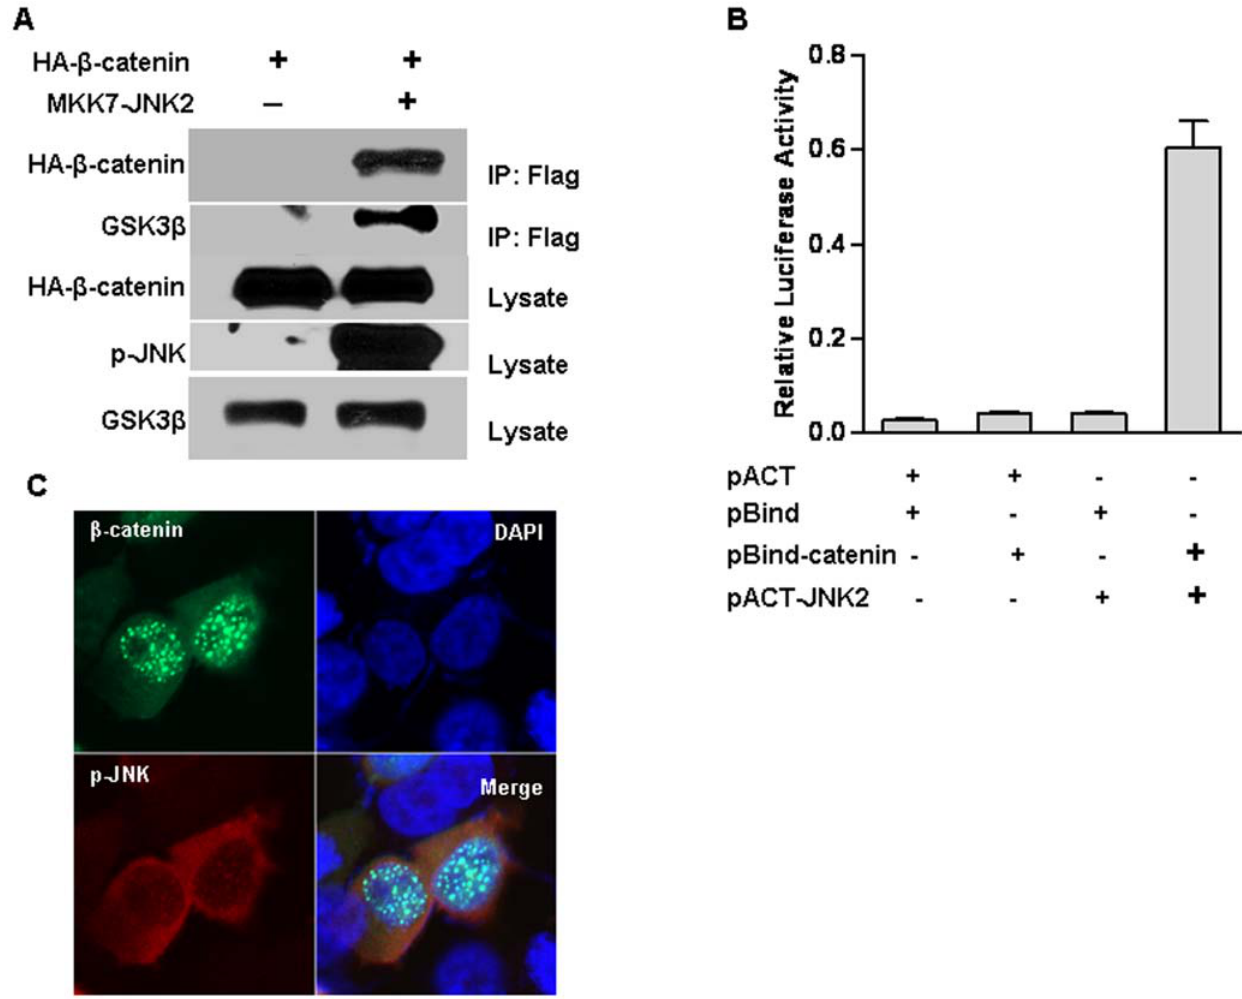
Figure 5. Activated JNK2 interacts with b -catenin and GSK3 b . ( A ) Active JNK2 binding to b -catenin and GSK3 b was analyzed by immunoprecipitation. b -catenin (HA tagged) was co-transfected with empty vector or active JNK2 (Flag tagged) into HEK293T cells. Immunoprecipitation was performed with a Flag antibody. ( B ) Mammalian two-hybridization assays showed a strong binding of b -catenin and JNK2 protein. The experiments were triplicated independently. ( C ) Active JNK2 and b -catenin co-localized in the cell nucleus and cytoplasm. Active JNK2 (Flag tagged) and pEGFP- b -catenin were co-transfected into HEK293T cells. The cells were immunostained with a Flag antibody. Co-localization (yellow fluorescence) of active JNK2 (red fluorescence) and b -catenin (green fluorescence) was detected in the nucleus and cytoplasm. (lane 4 versus 3), suggesting that GSK3 b is required for JNK2-